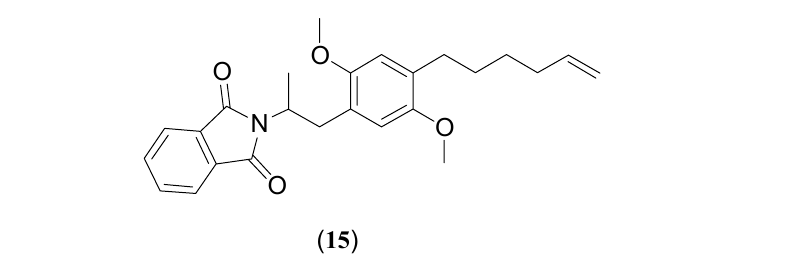
Figure 2. A potential side product formed during the synthesis of intermediates such as the chloro analogue of 8